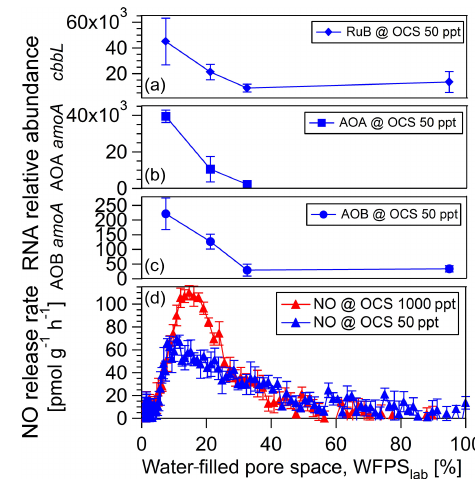
Figure 6. RNA relative abundance of the cbbL functional gene, en- coding ribulose-1,5-bisphosphate carboxylase (rubisco) large sub- unit type IA, measured over dry-out under 50ppt OCS (blue dia- monds, a ). RNA relative abundance of the amoA functional gene for ammonia-oxidizing archaea (AOA; blue squares, b ) and ammonia- oxidizing bacteria (AOB; blue points, c ) measured over dry-out un- der 50pptOCS. NO exchange rates at 50ppt (dark blue, d ) and 1000ppt (light blue, d ) OCS mixing ratio are shown for the A1 soil sample from a midlatitude corn field, Mainz,